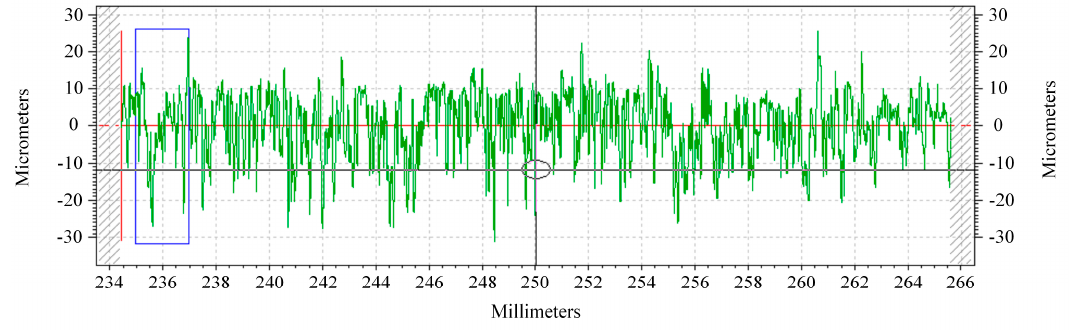
Figure 10. The form-truing error detected by a stylus profilometer.